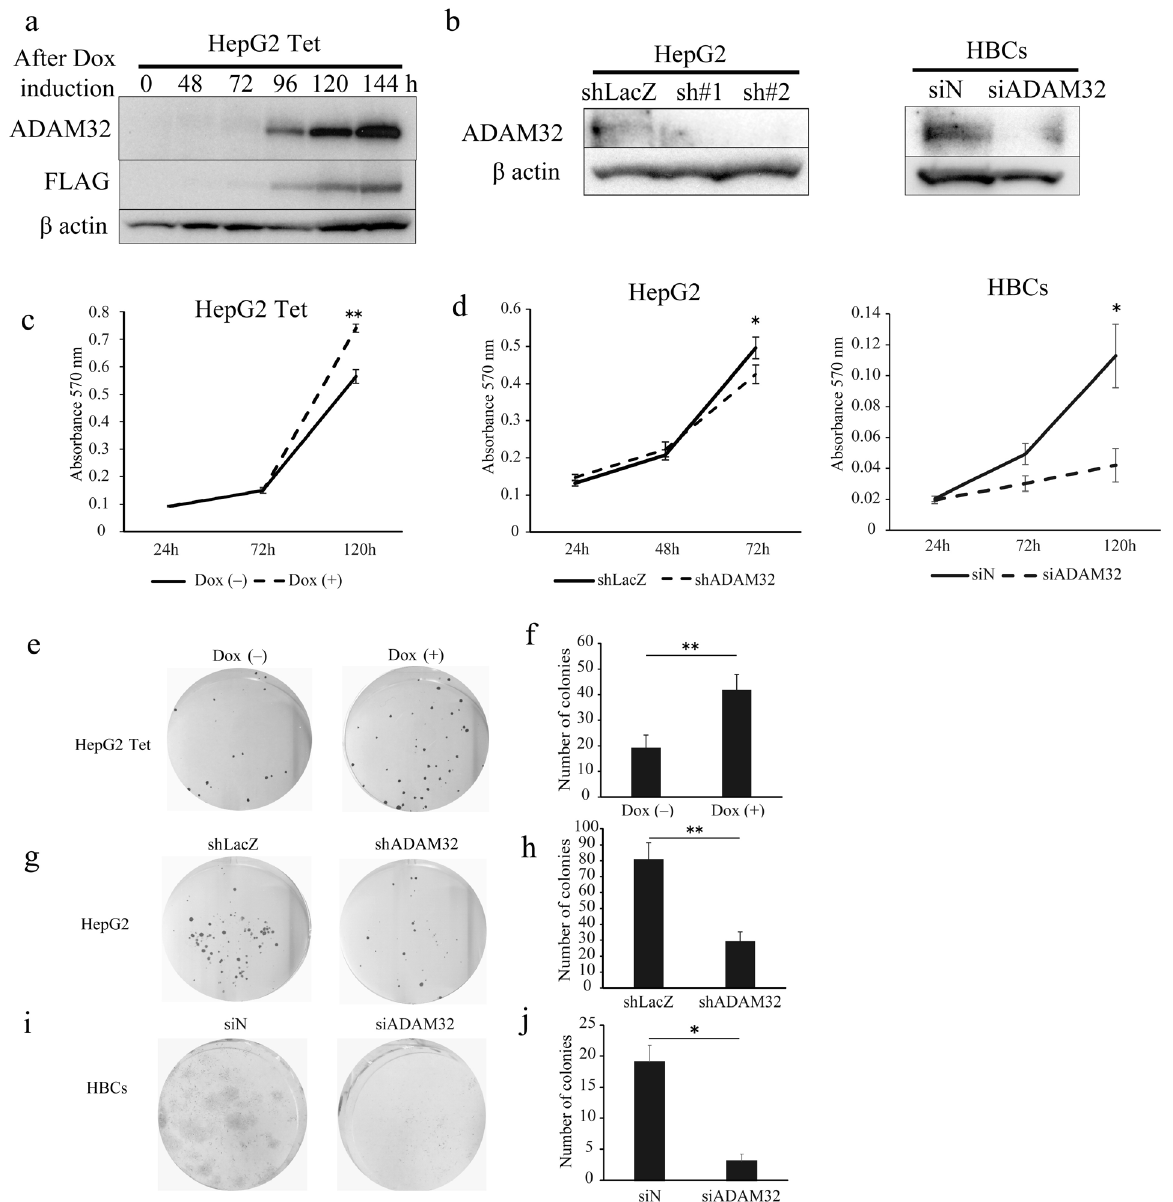
Figure 2. ADAM32 increases cell viability and colony formation in HBL and HBCs. ( a ) Immunob- lotting detection with anti-ADAM32 ( top ), anti-FLAG ( middle ), and anti- β actin ( bottom ) was con- ducted on whole-cell extracts prepared from HepG2 Tet at each time point. Representative images from three independent experiments are shown. ( b ) Immunoblotting showing expression levels of ADAM32 in HepG2 cells ( left ) and HBCs ( right ) transiently transfected with shRNA or siRNA. ( c ) Cell viability of HepG2 Tet cells (n = 3). ( d ) HepG2 cells ( left ) and HBCs ( right ) evaluated in the MTT assay (n = 3). Representative images of ( e ) HepG2 Tet, ( g ) HepG2, and ( i ) HBCs in the colony formation experiment. The number of colonies was counted, and the averages (and SE) are shown for ( f ) HepG2 Tet (n = 6), ( h ) HepG2 (n = 6), and ( j ) HBCs (n = 3). * p < 0.05; ** p < 0.01. All the whole immunoblotting figures can be found in Figure S11. When ADAM32 expression was forced, cell viability of HepG2 Tet in Group Dox (+) increased at 120 h (Figure 2c). Conversely, the knockdown experiment showed that cell viability of HepG2 in Group shADAM32 was significantly lower at 72 h than in Group shLacZ (Figure 2d). Cell viability of HBCs in Group siADAM32 was significantly lower at 120 h than in Group siN (Figure 2d). Moreover, the number of colonies increased in the colony formation experiment when expression of ADAM32 was forced (Figure 2e,f). By